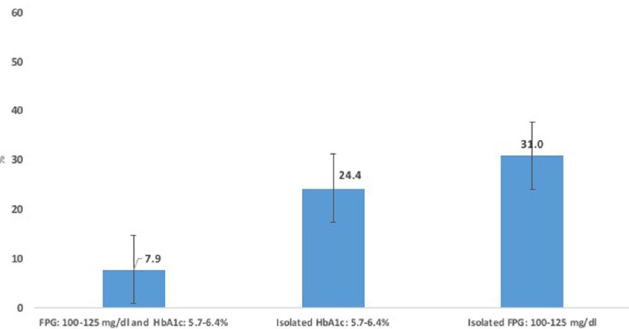
Figure 2. Proportion of patients reverting from prediabetes to normal glycaemia stratified by type of prediabetes.